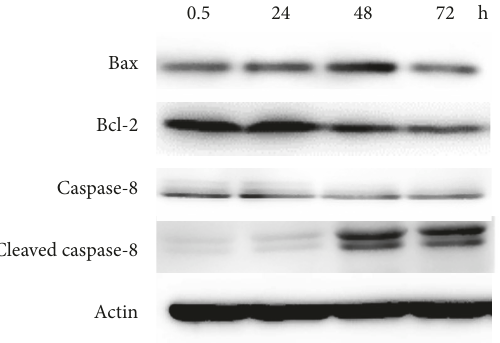
Figure 5: Apoptosis induction effect of ACE at half-IC 50 on protein expression of bax, bcl-2, caspase-8, and cleaved caspase-8 in HeLa cells using Western blot analysis. 𝛽 -actin served as an internal